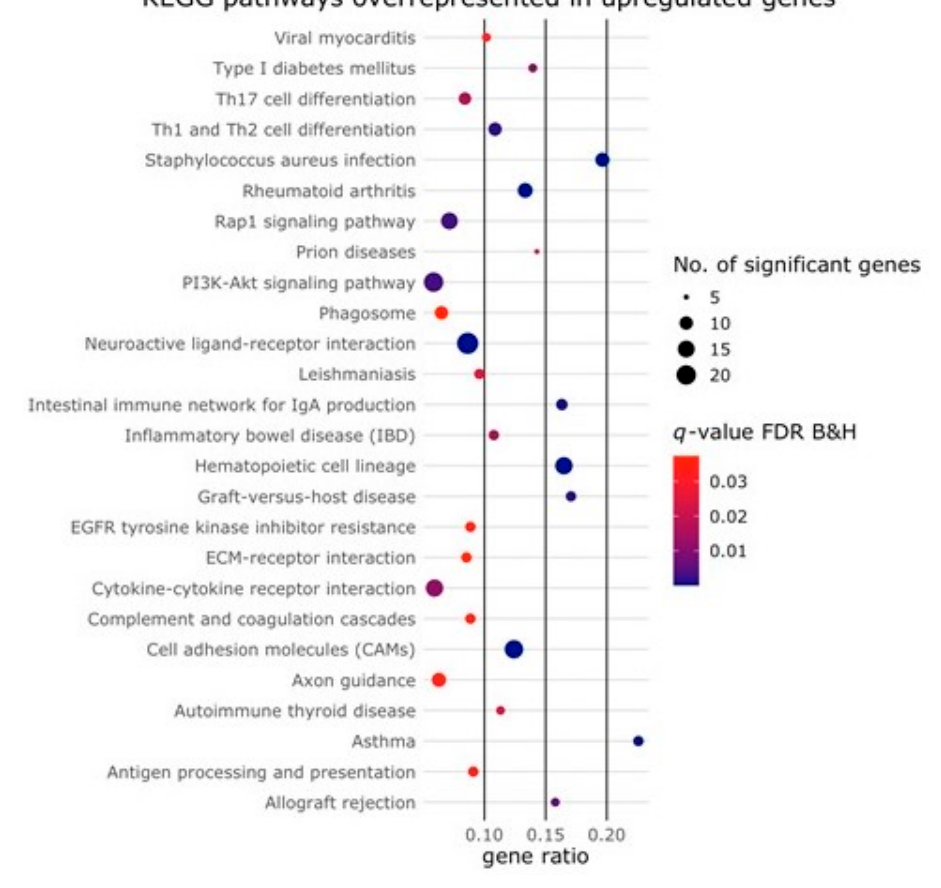
Figure 2. KEGG pathways enriched among the upregulated genes. Bubble plot showing KEGG pathways enriched among the genes upregulated by the Activin-A treatment. No enrichment was found among the downregulated genes. The size of the circle represents the number of DEGs ( p (adj) < 0.01, Log2 fold change ≥ 2) in that pathway. The color of the circle represents the significance depicted as a q-value, with default settings for the Benjamini–Hochberg false discovery rate (FDR B&H). The gene ratio represents the ratio between the number of DEGs in our dataset and the total number of genes in that pathway.